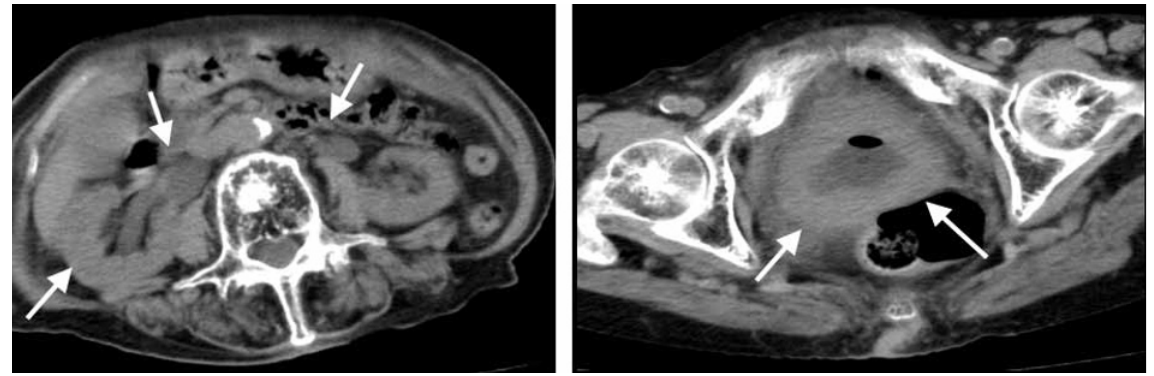
Figure 1. Plain abdominal computed tomography (CT) scan. Bilateral hydroureter and right hydronephrosis are observed. Thickening of the bladder wall is also observed. There are no abnormalities in the hepatobiliary